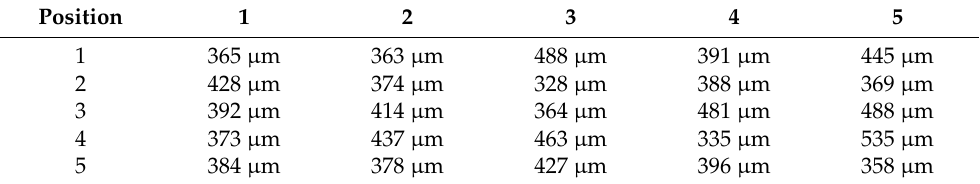
Table 5. Cavity bottom thickness.